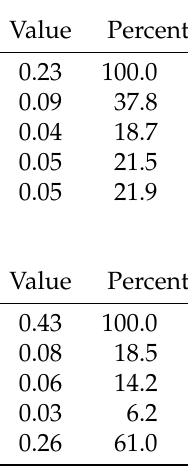
Table 7: Across-models Shapley decomposition of total bias in IGE g estimation. Biases with respect to lower-bound estimates Total bias Functional-form bias Attenuation bias Life-cycle bias Selection